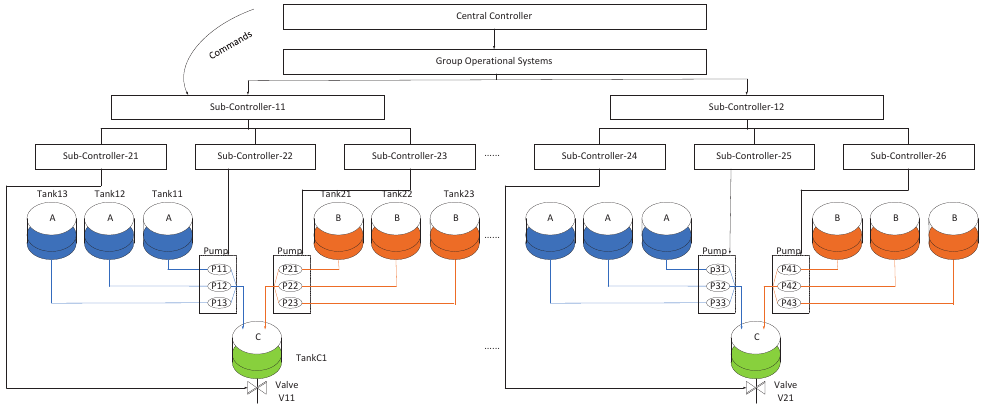
Figure 8. The structure of a tank